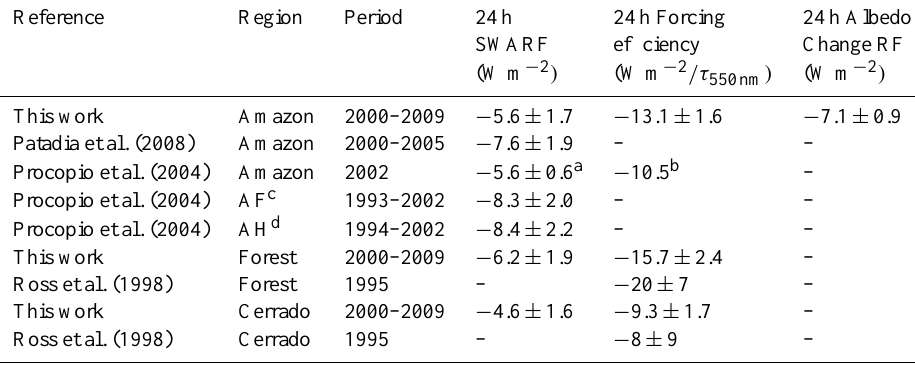
Table 6. Comparison of the aerosol and surface radiative forcing effects with previous studies. These results were calculated during the dry season (August and September) of the